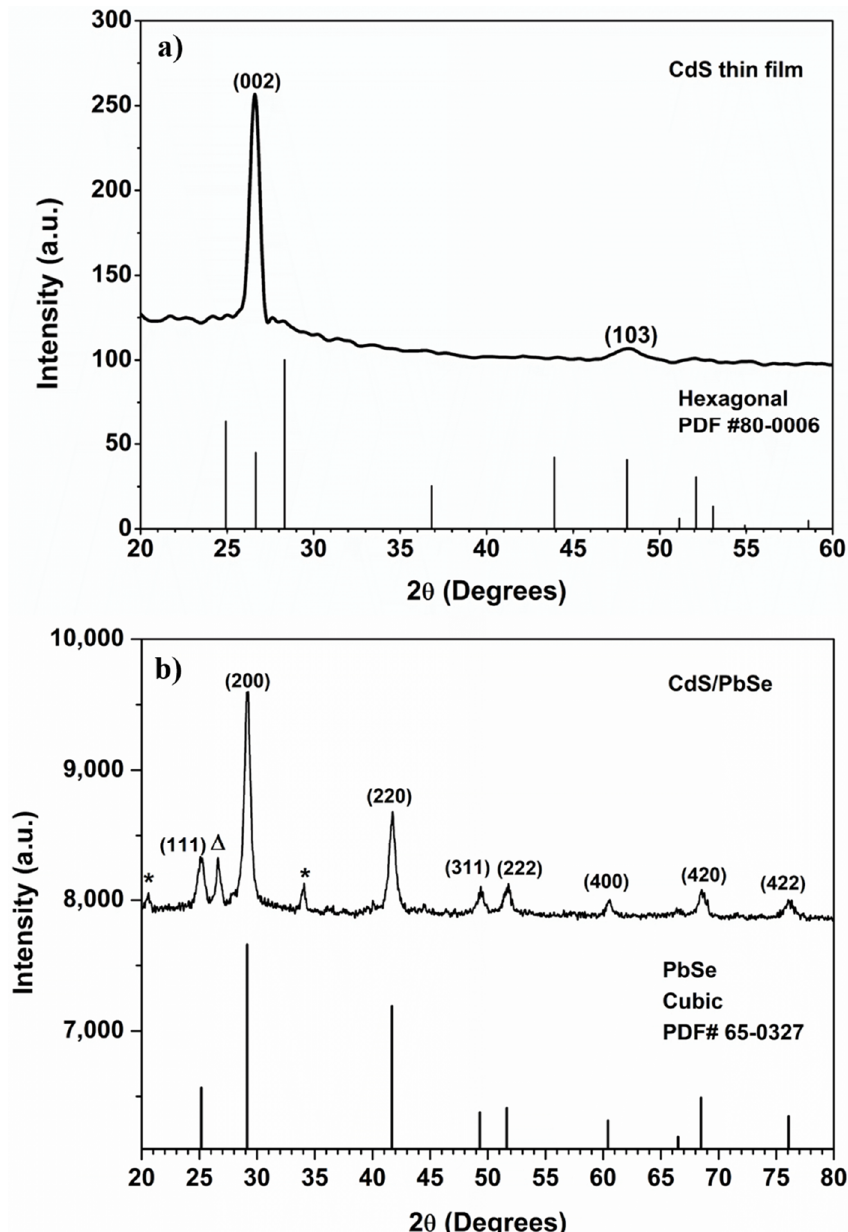
Figure 2. XRD diffractograms of ( a ) CdS thin films, and ( b ) CdS/PbSe.